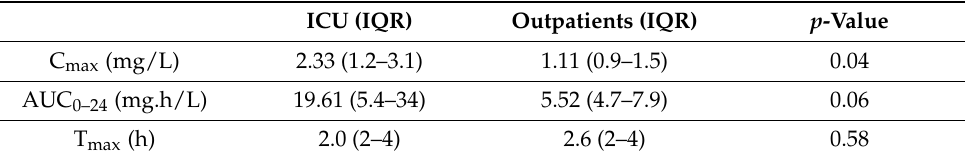
Table 2. Comparative C max , AUC (0–24) and T max of ethambutol for ICU and